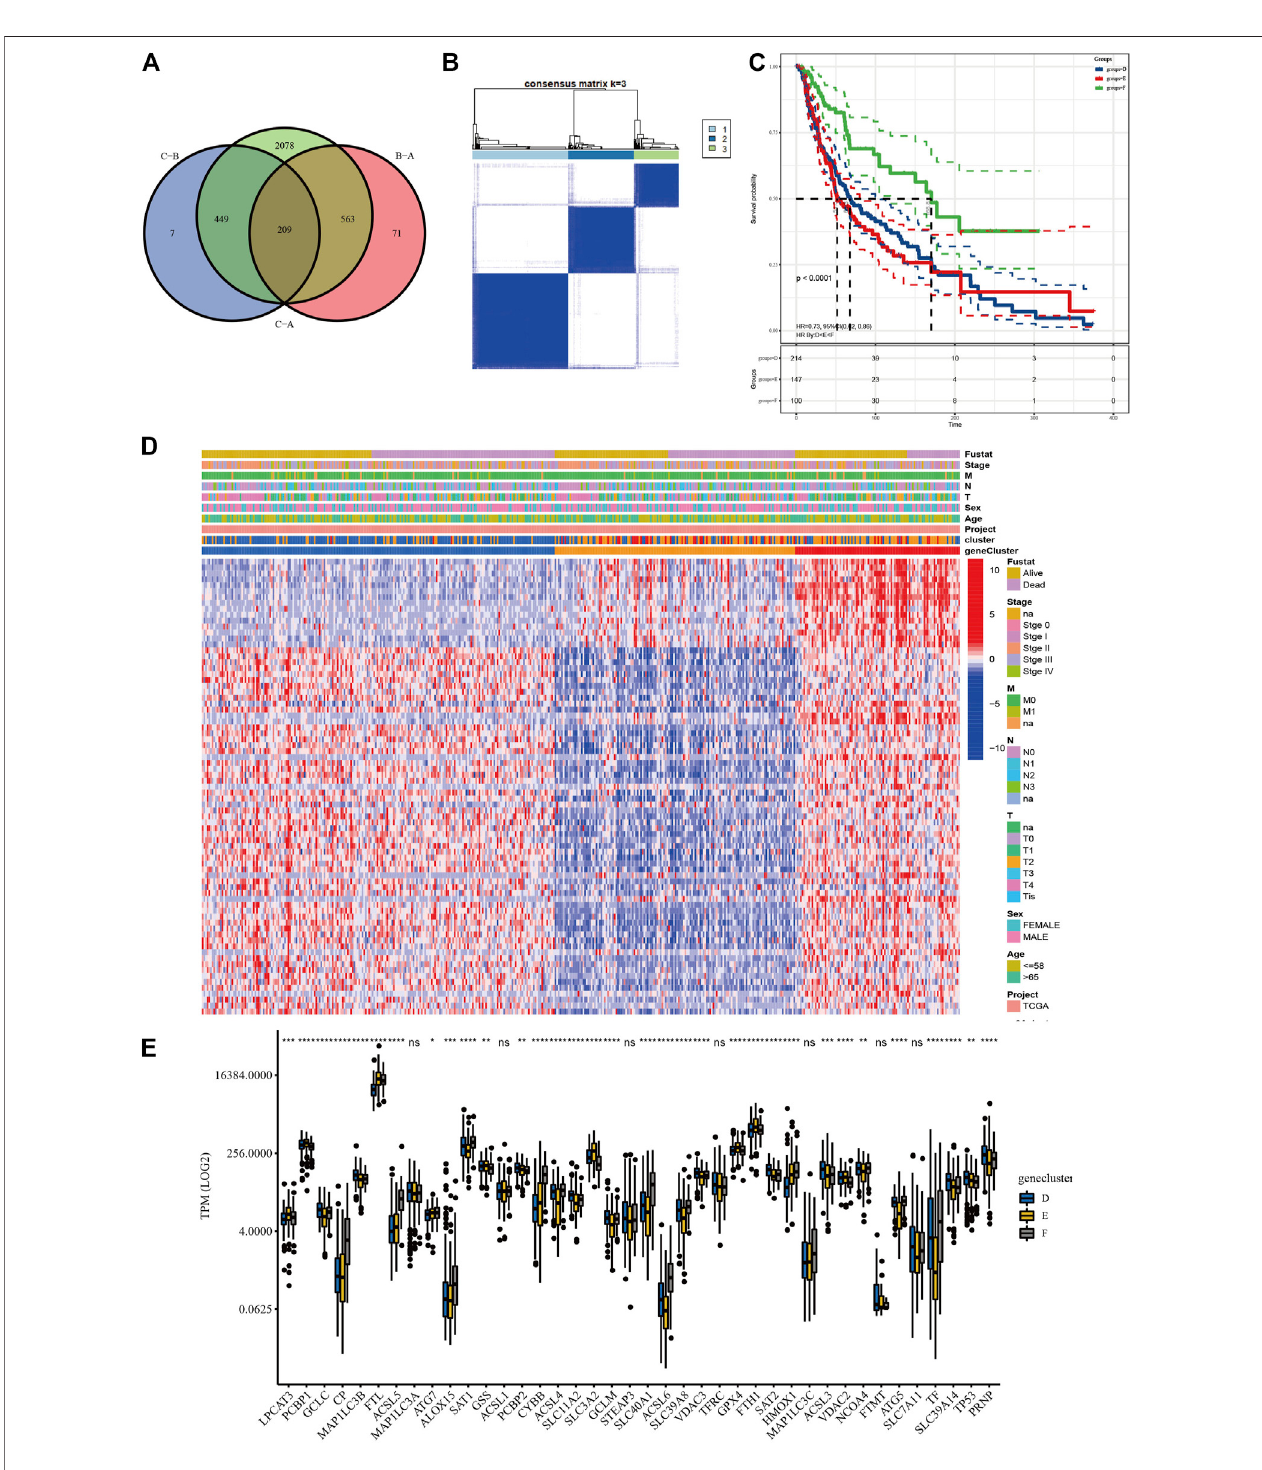
FIGURE 4 | Screening and validation of prognostic lncRNAs. (A) Venn diagram revealed the common differentially expressed lncRNAs (DElncRNAs). (B) Consensus clustering of SKCM patients based on the expression of 77 prognostic long non-coding RNAs (lncRNAs) ( k (cid:1) 3). (C) The overall survival (OS) analysis of SKCM patients in geneclusters D, E, and F, and genecluster F showed the most satis fi ed prognosis. (D) The heatmap of geneclusters D, E, and F with detailed clinicopathological information, where patients in genecluster F had better prognosis. (E) Signi fi cant differences in TPM values of ferroptosis-related genes among the three subgroups (**** p < 0.0001; *** p < 0.001; ** p < 0.01; * p < 0.05).